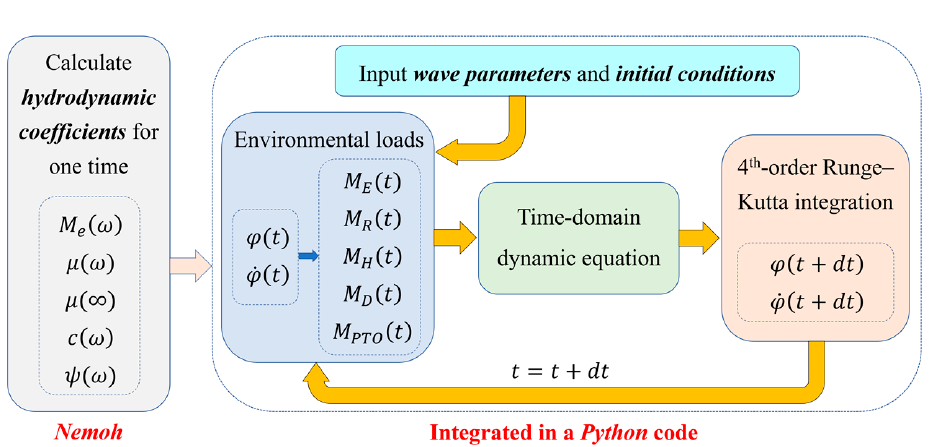
Figure 3. A workflow of solving the dynamic equation in Nemoh and Python.